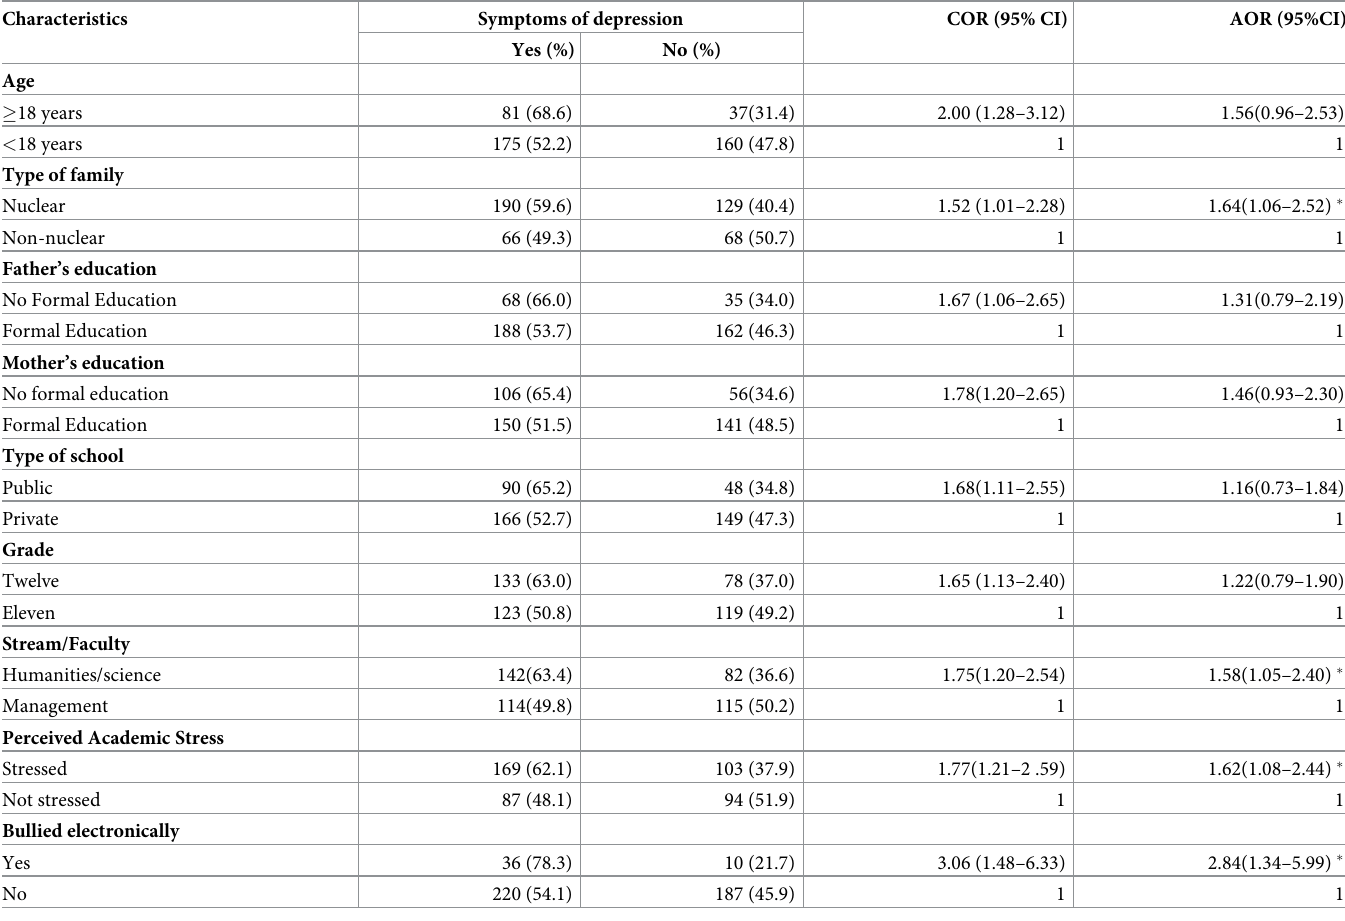
Table 4. Factors associated with symptoms of depression among the high school students of an urban municipality in Kathmandu (n = 453).